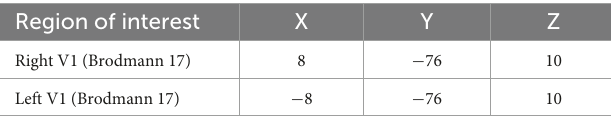
TABLE 1 Montreal Neurological Institute coordinates for region of interest.